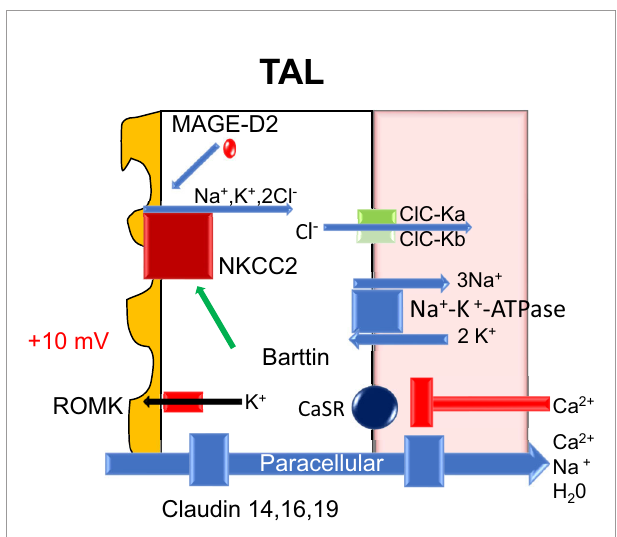
FIGURE 5 | Nephron molecular calcium handling-loop of Henle: ATPase, adenosine triphosphatase; CaSR, calcium sensing receptor; Ca 2+ , calcium; Cl - , chloride; H20, water; K + , potassium; mV, millivolt; Na + , sodium; NKCC2, sodium potassium two chloride transporter; ROMK, apical renal outer medullary potassium channel; TAL, thick ascending of Henle; ClC-Ka, chloride channel kidney A; ClC-Kb, chloride channel kidney B; MAGED-2, melanoma-associated antigen